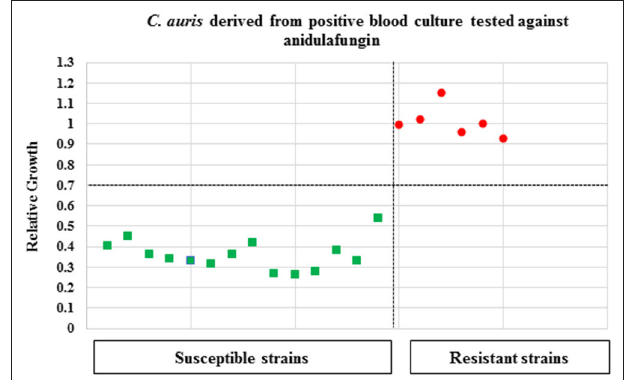
FIGURE 2 | Comparison of CLSI microdilution MICs and MBT ASTRA MICs for C. auris isolates ( n = 50) against anidulafungin. For each isolate, the MIC value derived by MBT ASTRA ( y axis) was plotted against the MIC obtained by microdilution (x axis) for anidulafungin. The colored boxes indicate the MIC ranges according to CLSI; green, susceptible and red, resistant. The horizontal dashed line indicates the suggested cutoff defined for MBT ASTRA MIC, and the vertical dashed line shows the suggested cutoff determined for CLSI. A high agreement was observed between both approaches, and only one isolate susceptible against anidulafungin was wrongly detected by MBT ASTRA.